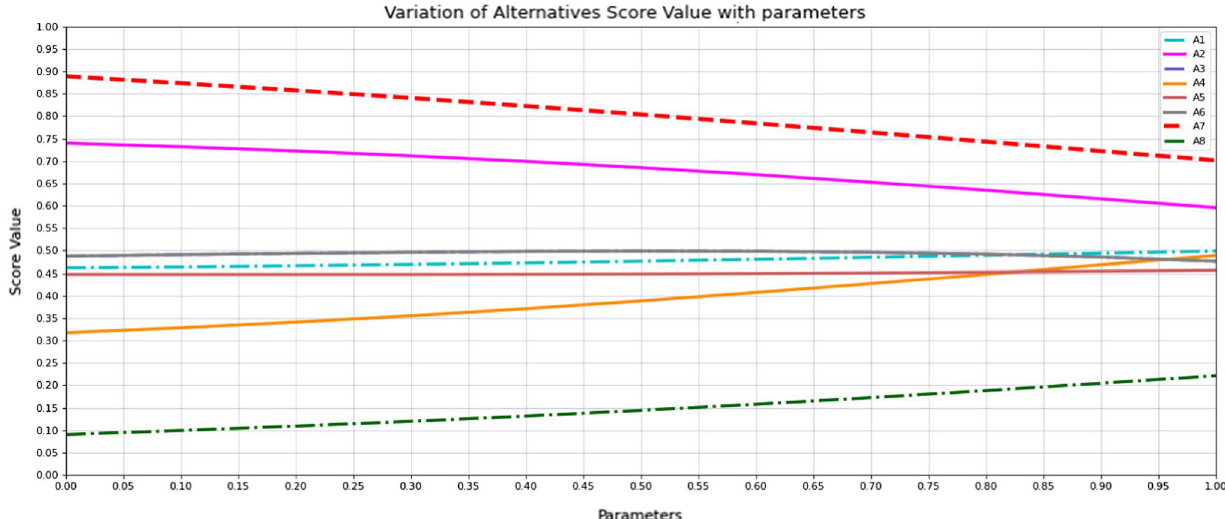
Fig. 5 Robust analysis results of hotel ranking with parameters